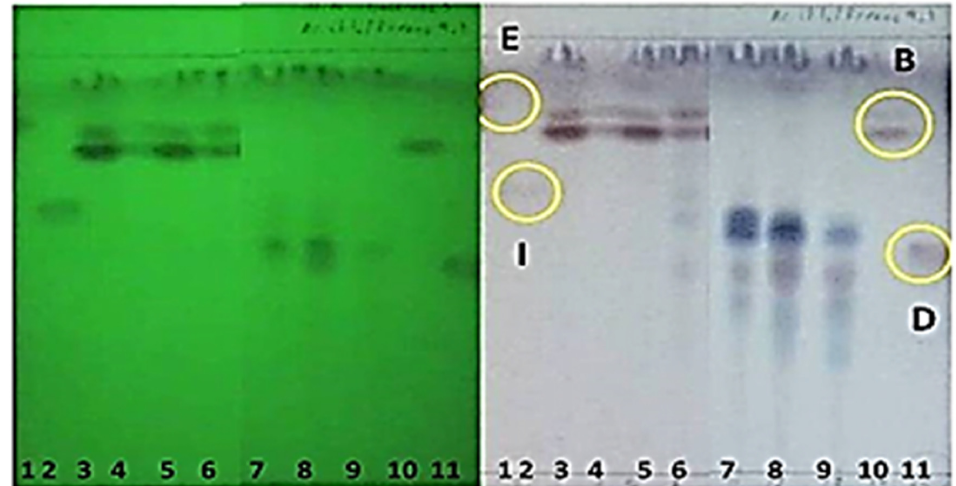
Figure 5. Preliminary identification of cucurbitacins by thin-layer chromatography (TLC) on the extract of S. edule cv . Madre Negra. (The fractions came from the separation/purification of the DCM extract). Lanes 1 and 2 are cucurbitacin E and D. Lanes 3–9 correspond to the fractions indicated in Table 2. Lanes 9 and 10 are cucurbitacins B and I. Table 2. Relation of the cucurbitacin standards E, B, D, and I with fraction three (rf: 0.73, 0.63, and